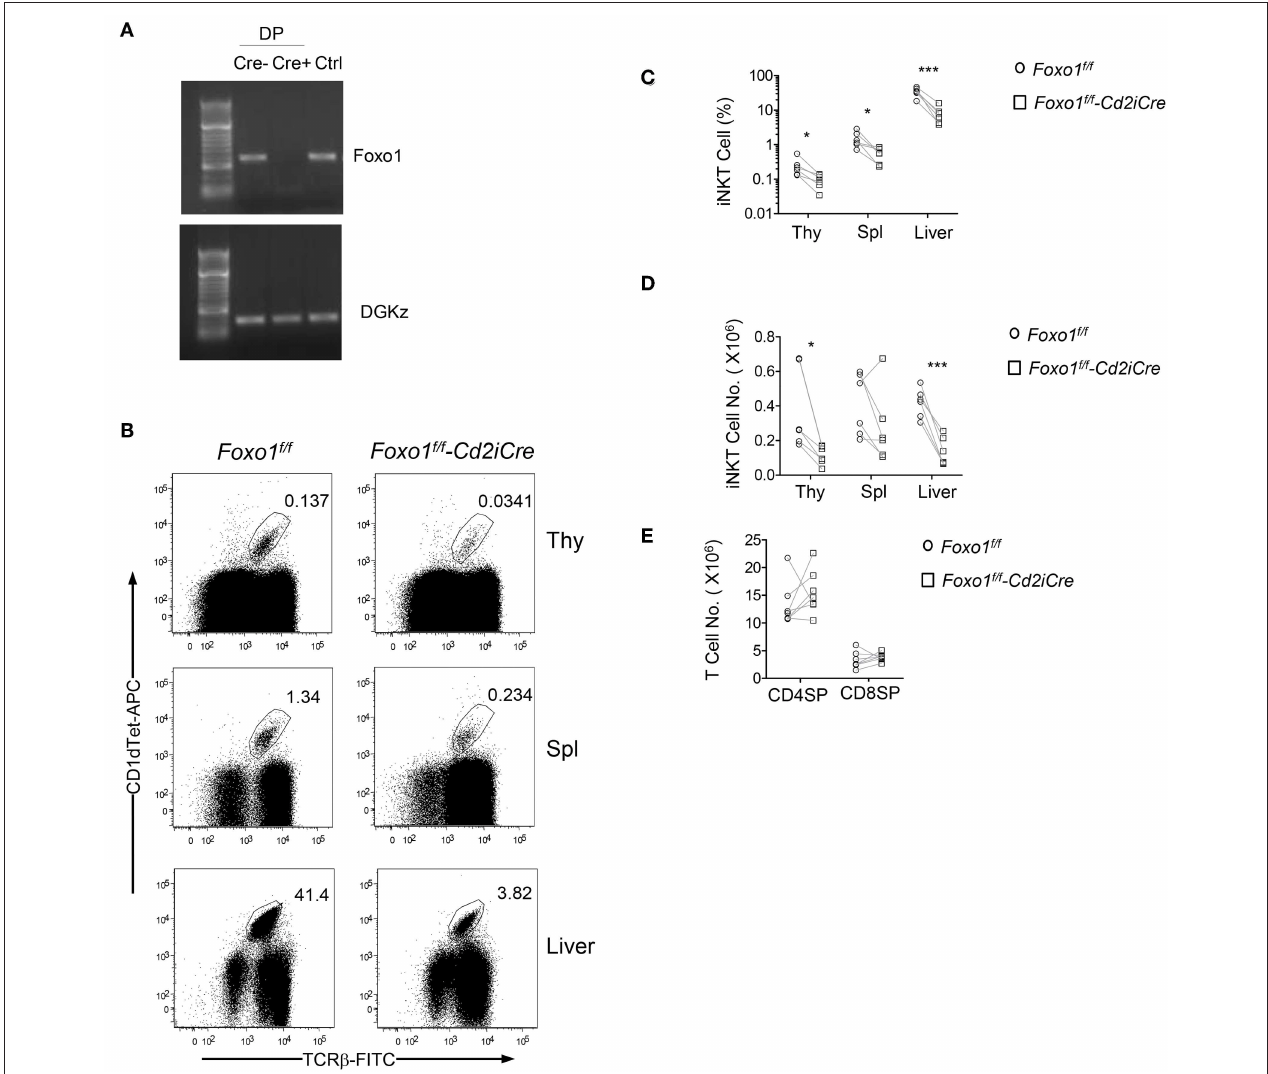
FIGURE 1 | Severe decreases of i NKT cells in Foxo1 f / f -Cd2iCre mice. Six to ten weeks old Foxo1 f / f -Cd2iCre (Foxo1KO) and Foxo1 f / f or Cd2iCre controls (Ctrl) mice were analyzed for i NKT cells by flow cytometry. (A) Assessment of Cre mediated deletion in Foxo1 gene in DP thymocytes. Cre mediated recombination causes deletion of the PCR template. Cre–: Foxo1 f / f ; Cre + : Foxo1 f / f -Cd2iCre ; Ctrl: tail DNA from Foxo1 f / f -Cd2iCre mice. (B) TCR β and CD1dTet staining of thymocytes, splenocytes, and liver mononuclear cells (MNCs). Live gated Lin-singlets are shown. (C) Percentages of i NKT cells in the indicated organ. (D) Numbers of i NKT cells in the indicated organs. (E) TCR β + SP thymocyte numbers. FACS plots are representative of five experiments. Scatter plots are pooled from five experiments (C,D) or seven experiments (E) . Each circle and square represents one WT and one Foxo1KO mice, respectively. Connecting lines indicate individual pairs of sex- and age-matched test and control mice in each experiment. One pair of mice was examined in each experiment. * p < 0.05; *** p < 0.001 determined by two-tail pair-wised Student t -test.